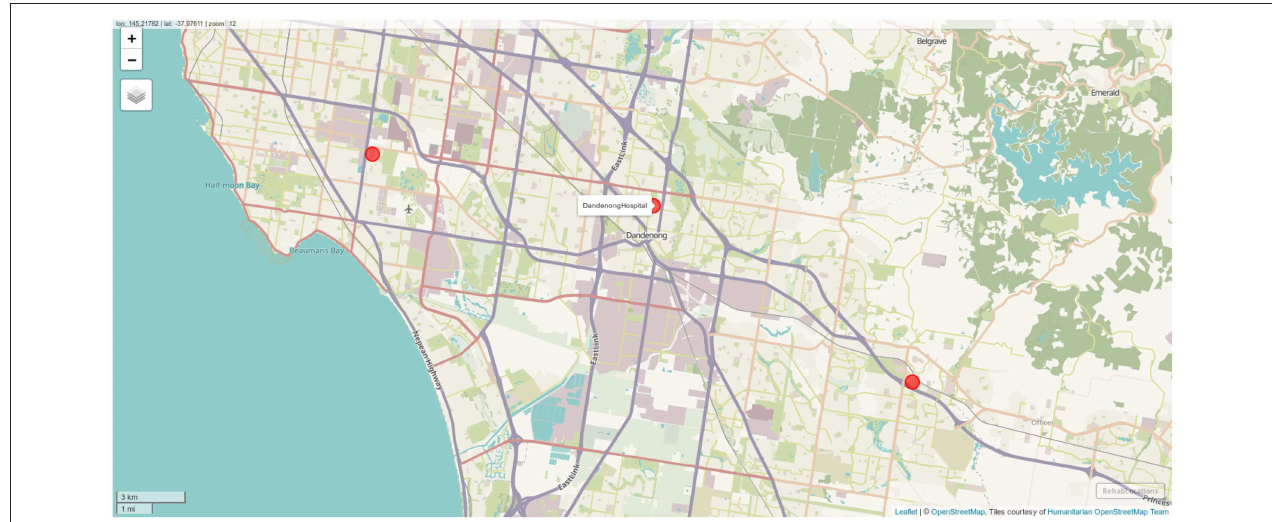
FIGURE 3 | Locations of the three rehabilitation centers determined by geocoding. Screenshot of interactive visualization created with mapview .